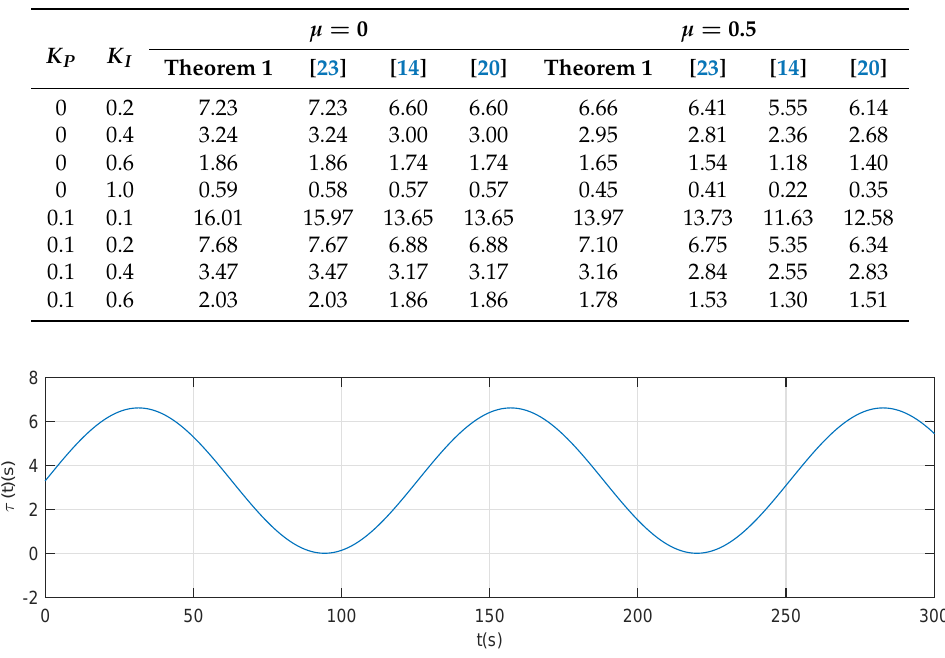
Figure 5. Time-varying delays τ ( t ) = 3.3 sin ( 0.05 t ) + 3.3.